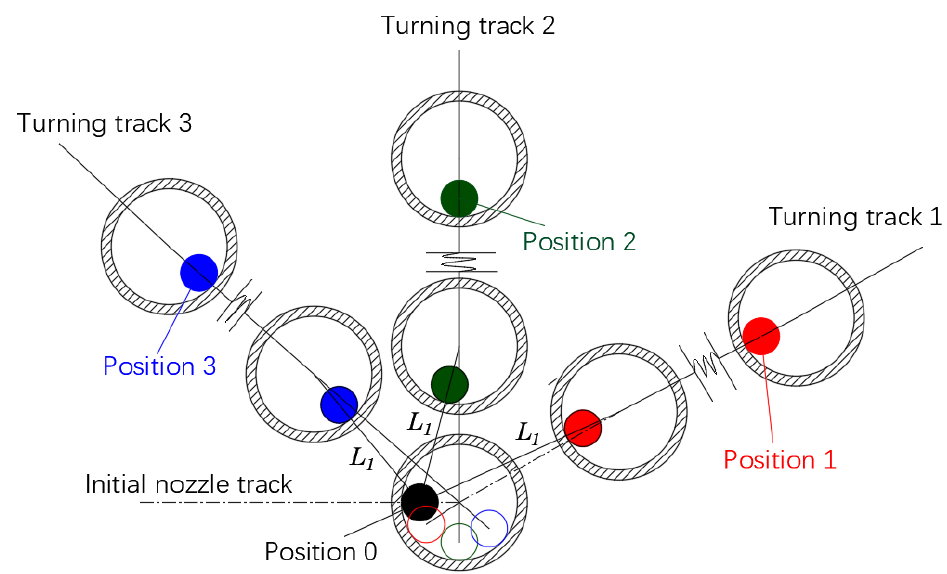
Figure 13. Schematic diagram of following at different corner angles.